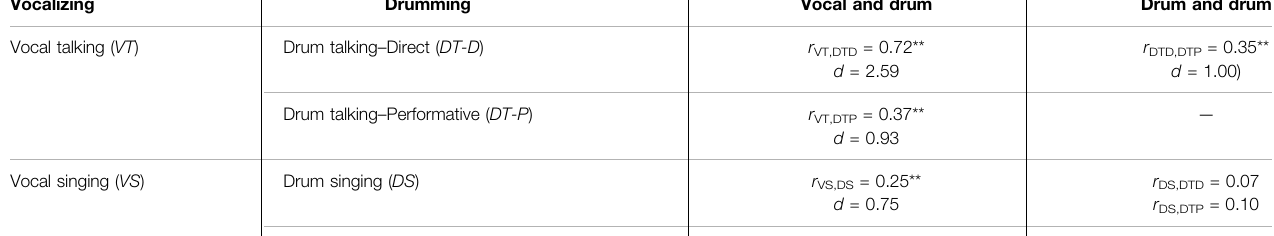
TABLE 3 | Average timing correlations of syllabic occurrences between different modes of vocalizing and drumming on the same verbal-musical sequence. One-sample t -tests comparing correlation coef fi cients to a null set are included below average correlations. Vocalizing Drumming Vocal and drum Drum and drum